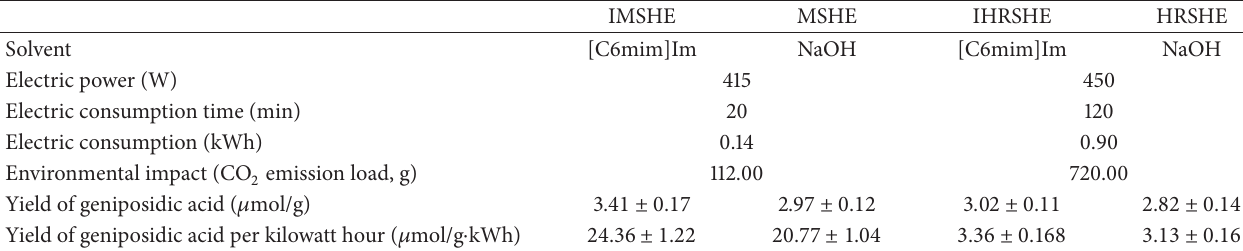
Table 3: Comparison of economic effect and environmental impact with different methods, mean ± SD ( 𝑛 = 3